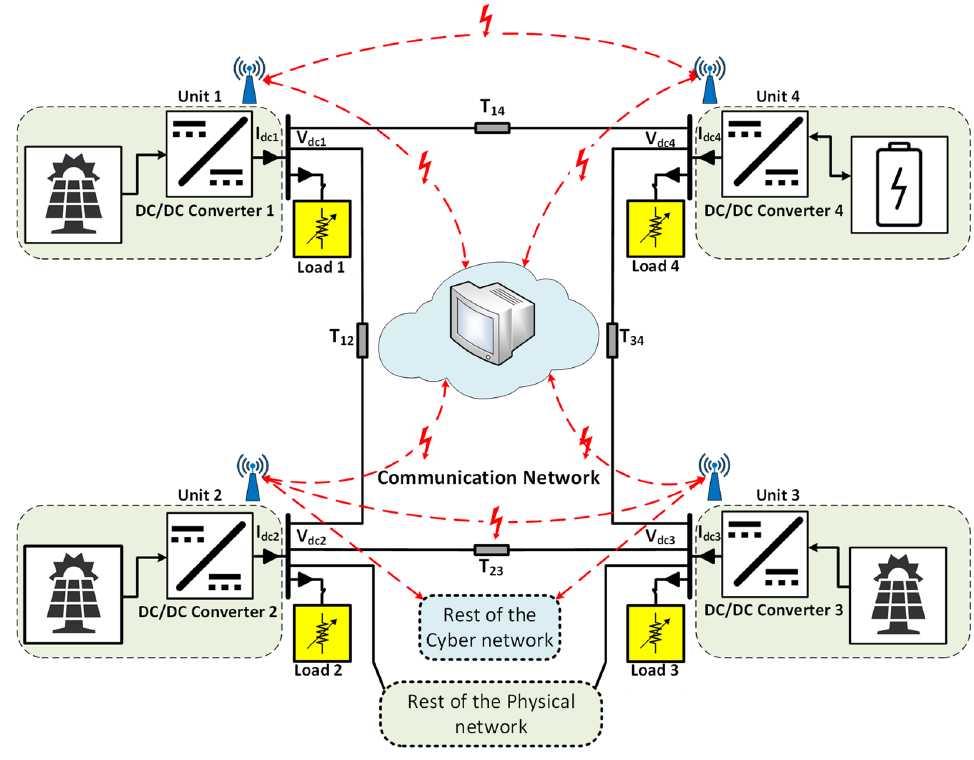
Figure 3. The testbed DCMG with the related communication network (adapted from [13]).